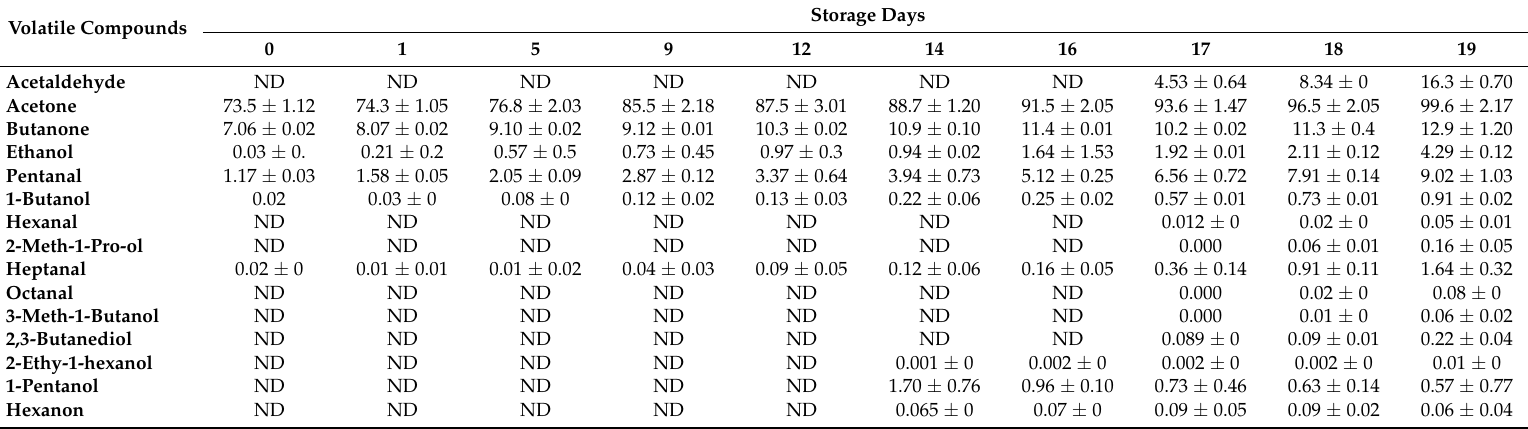
Table 2. Means values and standard deviation of volatile compounds ( µ g/L) of pasteurized milk stored at 7 ◦